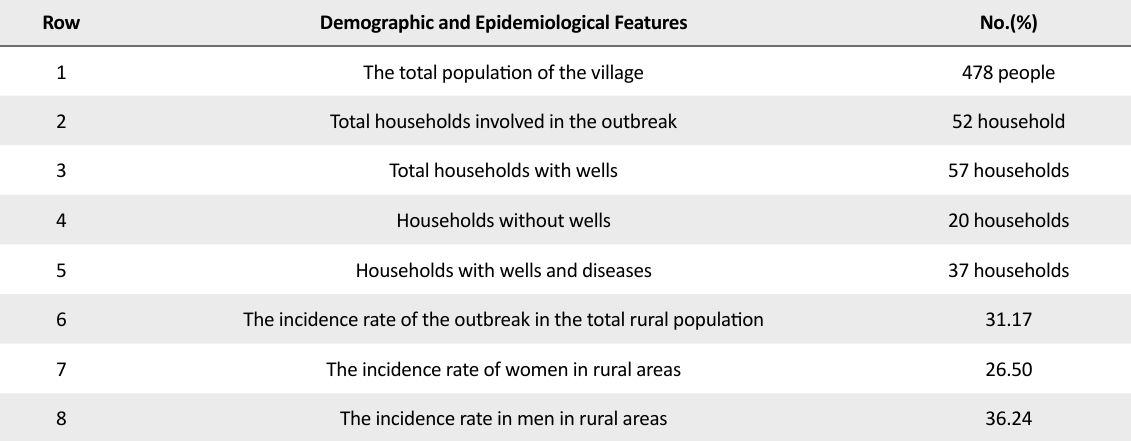
Table 1. Demographic and epidemiological features of the outbreak in Kurdistan Province, Iran Row Demographic and Epidemiological